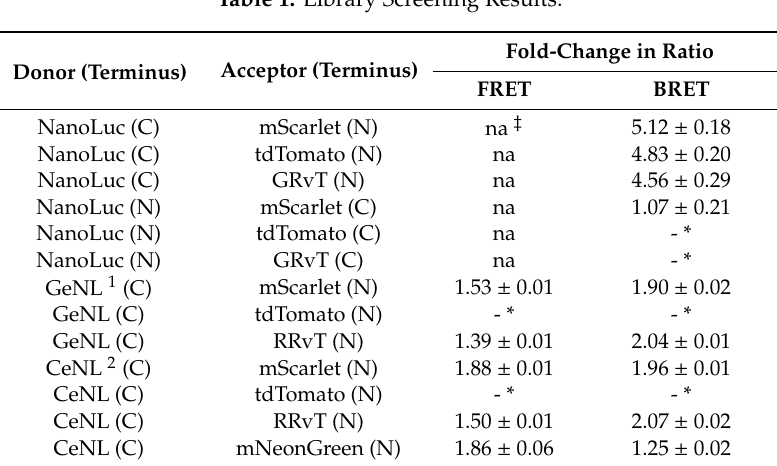
Table 1. Library Screening